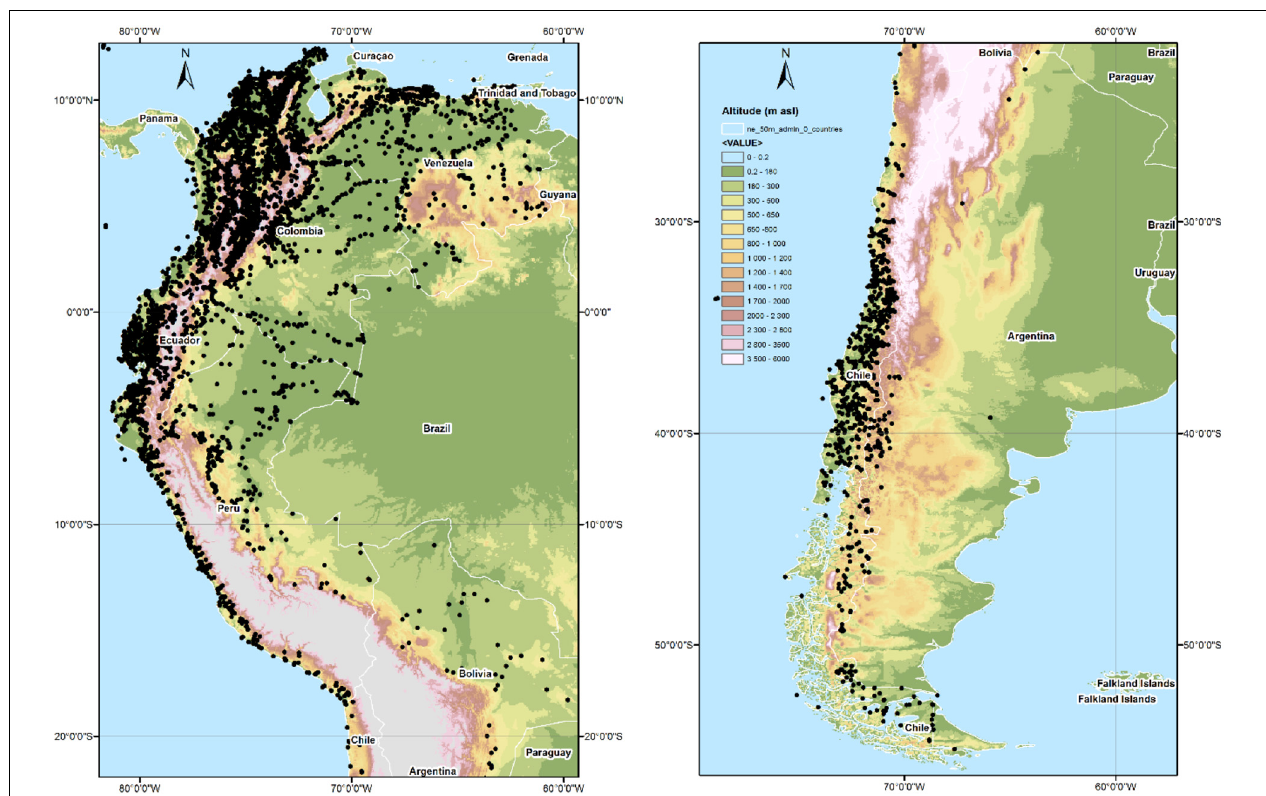
FIGURE 1 | Total number of surface stations (meteorological and hydrological) between 0 and 1000 m. Source: National Meteorological and hydrological Services from Bolivia, Chile, Colombia, Ecuador, Peru, Venezuela, and Argentina.